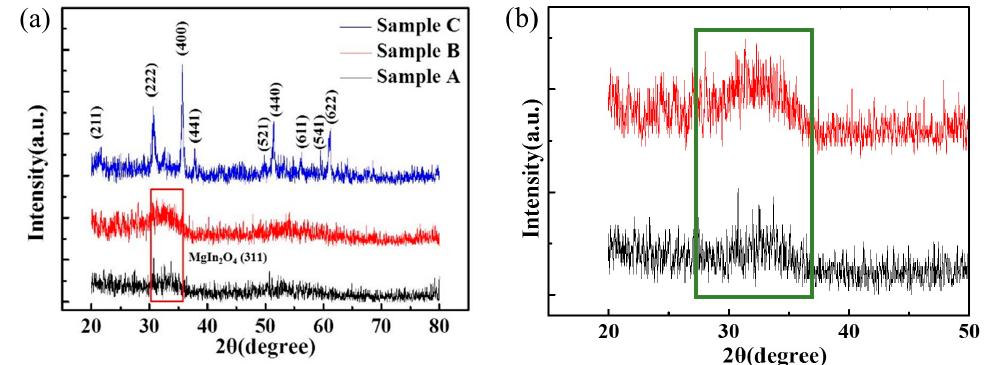
Figure 1. ( a ) Glancing incidence angle X-ray diffractometry (GIAXRD) spectra of three samples. ( b ) The magnified picture of the (311) diffraction line of the MgIn 2 O 4 phase.